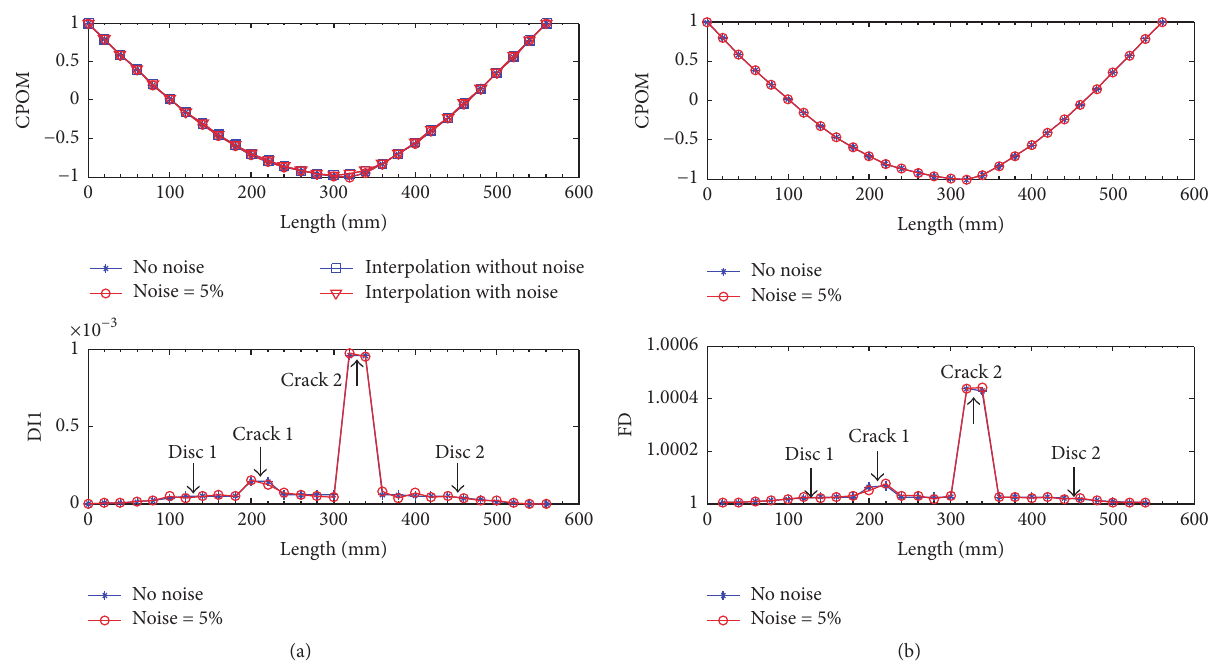
Figure 9: Localization results of double-cracked rotor in case 2. (a) Localization using GSM by linear gapped interpolation. (b) Localization using FD.